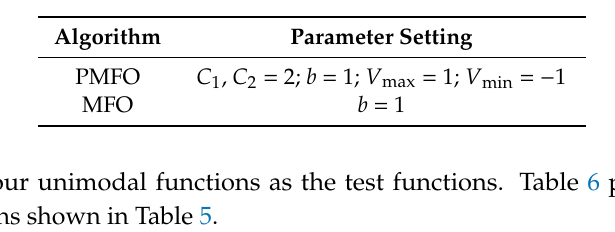
Table 4. Parameter setting of the validated algorithms.